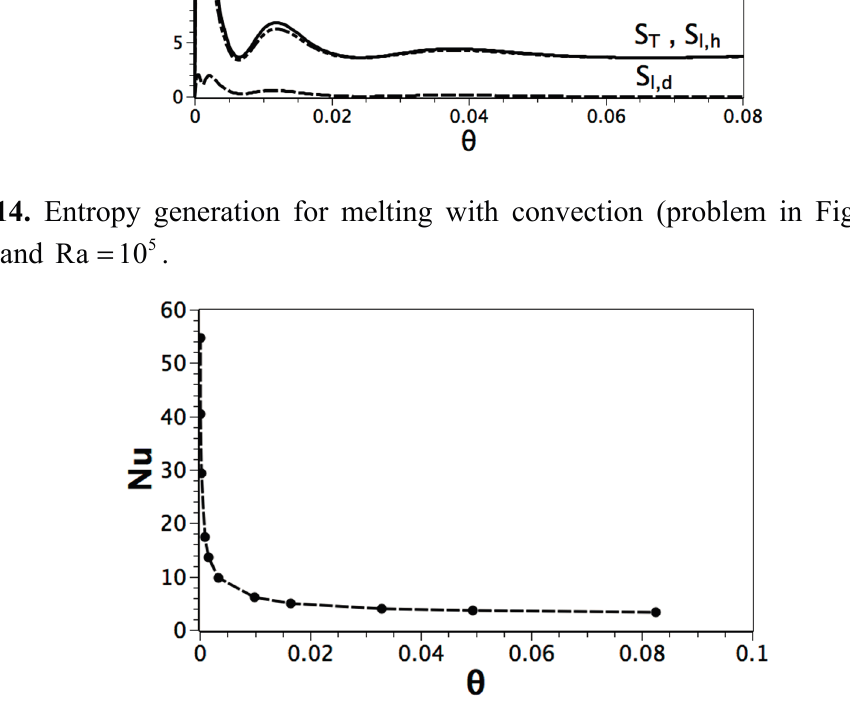
Figure 15. Nu versus dimensionless time (problem in Figure 1b) for Pr 50 = and 5 Ra 10 =